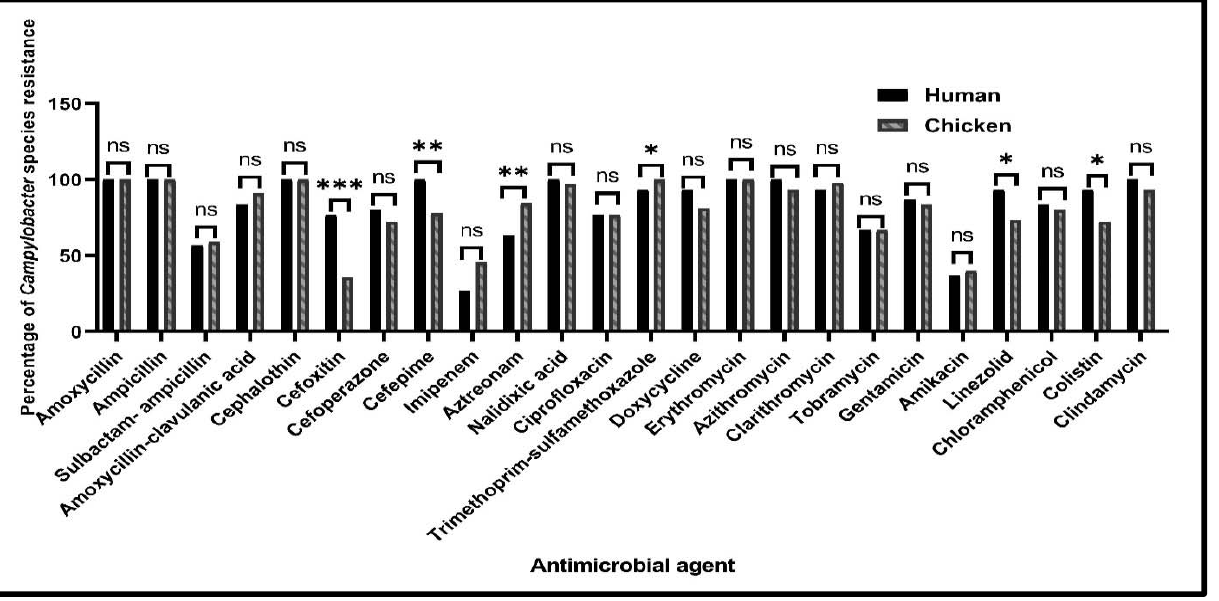
Figure 2. Prevalence of Campylobacter species resistance among human and chicken sources. ns: non-significant, * p < 0.05, ** p < 0.01, *** p < 0.001.